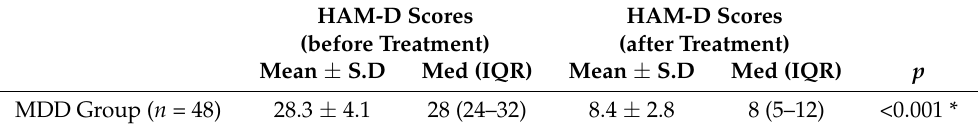
Table 4. HAM-D scores before and after treatment in the MDD